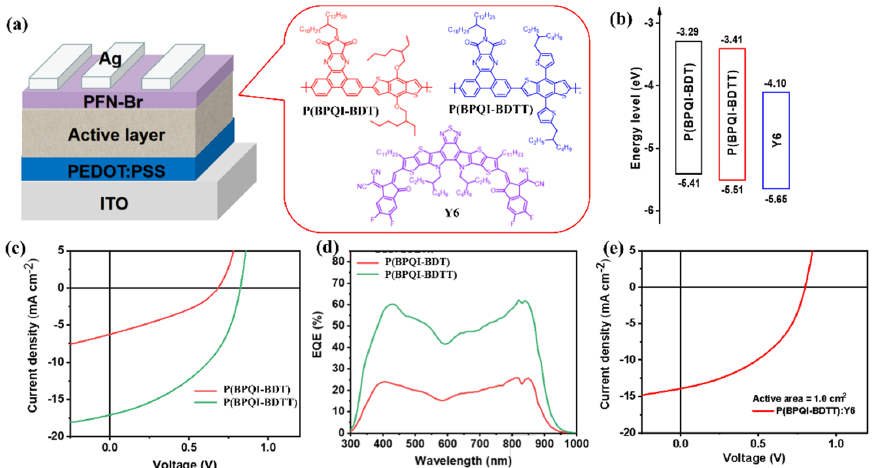
Figure 3. ( a ) Structure of P(BPQI ‐ BDT) or P(BPQI ‐ BDTT) as the polymer donor and Y6 as the acceptor; ( b ) the molecular energy levels of BPQI ‐ BDT, BPQI ‐ BDTT, and Y6; ( c ) vurrent density–applied voltage ( J–V ); ( d ) external quantum efficiency (EQE) curves of P(BPQI ‐ BDT):Y6 or P(BPQI ‐ BDTT):Y6 devices; ( e ) P(BPQI ‐ BDTT):Y6 ( J ‐ V ) curve when active area is 1 cm 2 .